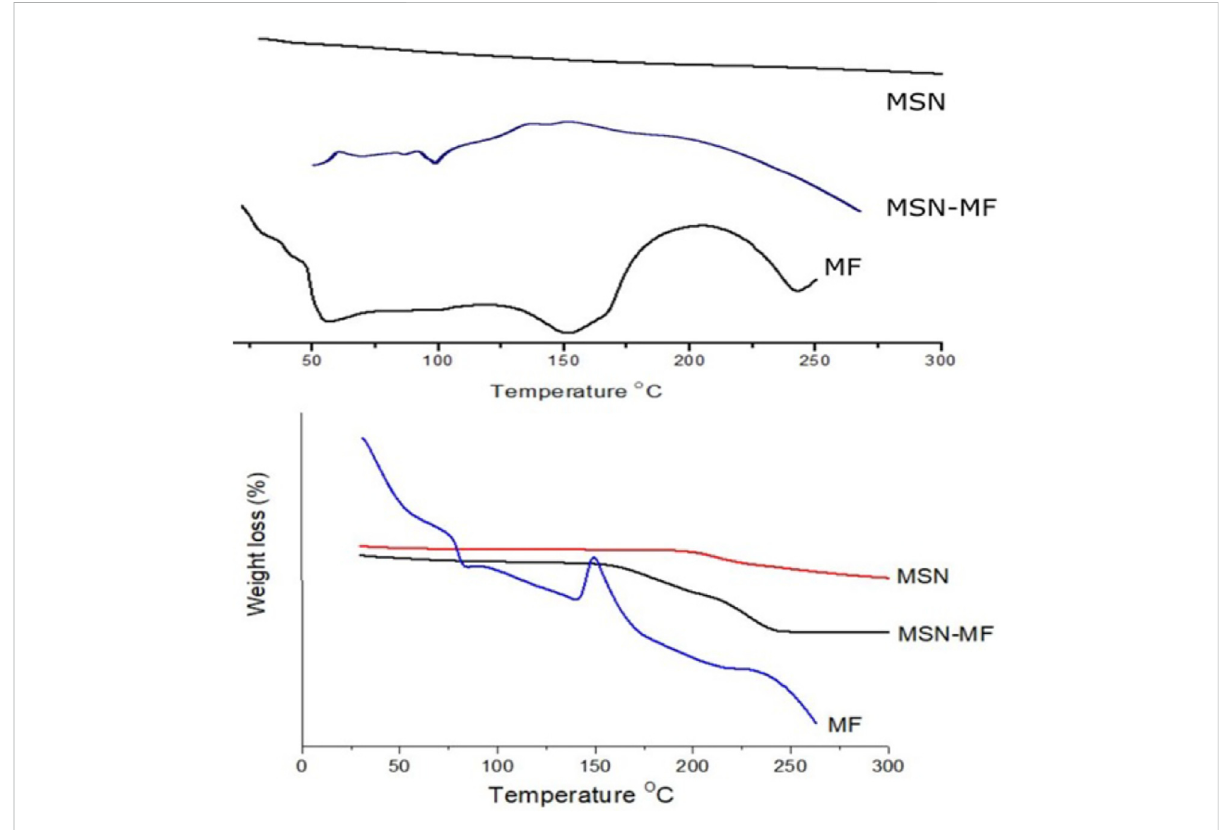
FIGURE 3 Thermal analysis of MSN, MF, and